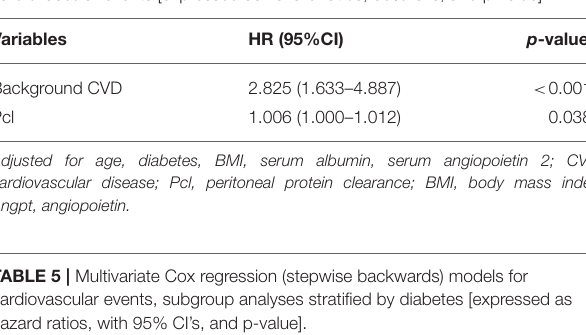
TABLE 5 | Multivariate Cox regression (stepwise backwards) models for cardiovascular events, subgroup analyses stratified by diabetes [expressed as hazard ratios, with 95% CI’s, and p-value].